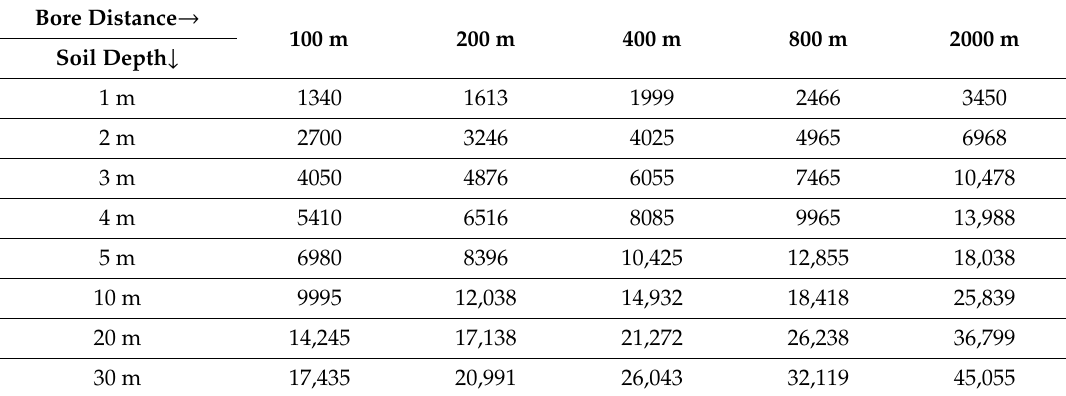
Table 2. Combined dilution factor for the soil-groundwater pathway for the loam soil and